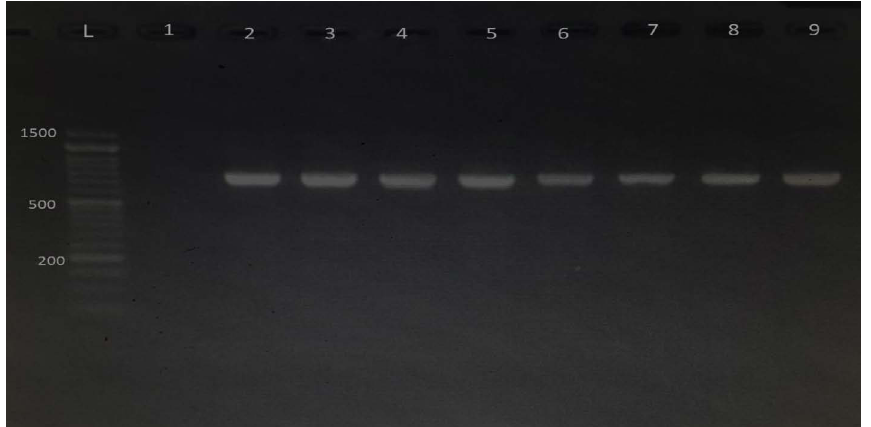
Fig. 4. Gel electrophoresis of PCR products of fyuA gene visualized under U. V light after mixed with ethidium bromide. L: 1500 bp DNA marker; lane 2-9 positive for fyuA gene and lane 1 negative result. The product size is 880 bp.